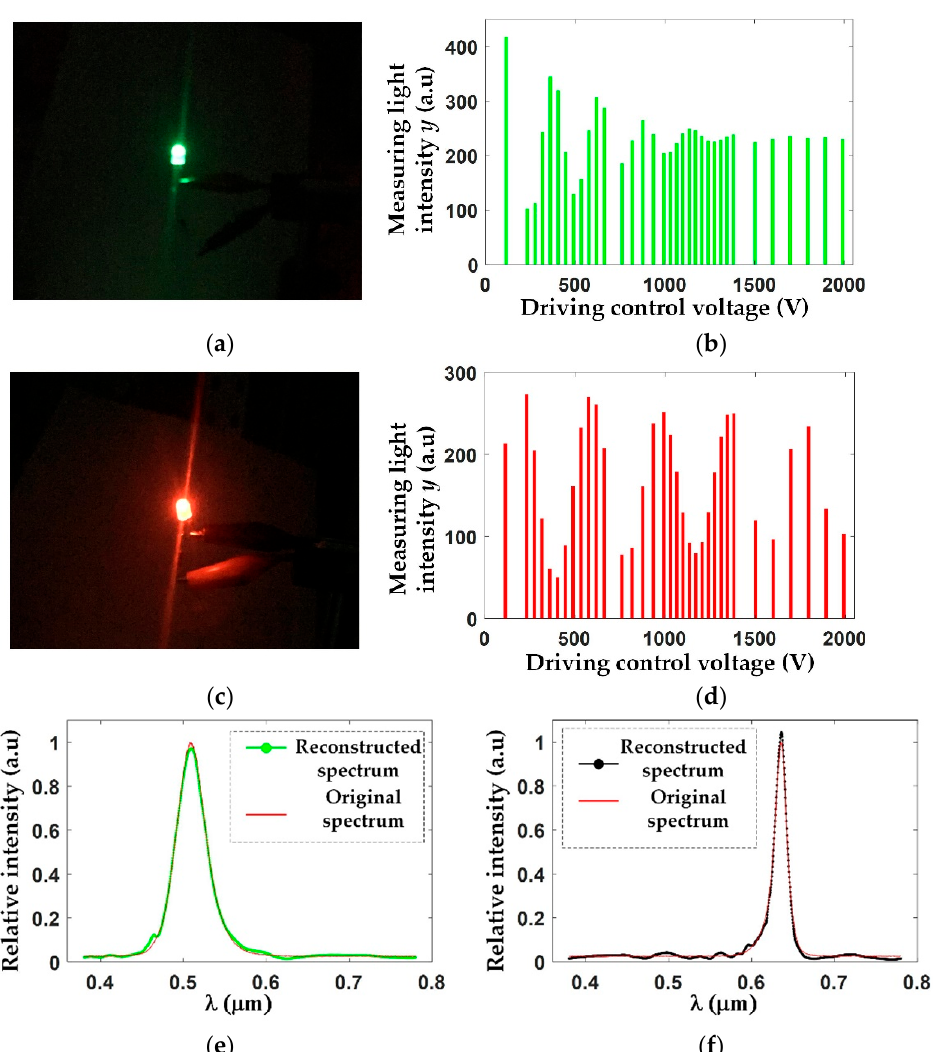
Figure 7. LED light source spectrum measurement: ( a ) Green LED light source; ( b ) Green LED measurement signal; ( c ) Red LED light source; ( d ) Red LED measurement signal; ( e ) Green LED spectrum reconstruction result; ( f ) Red LED spectrum reconstruction result.